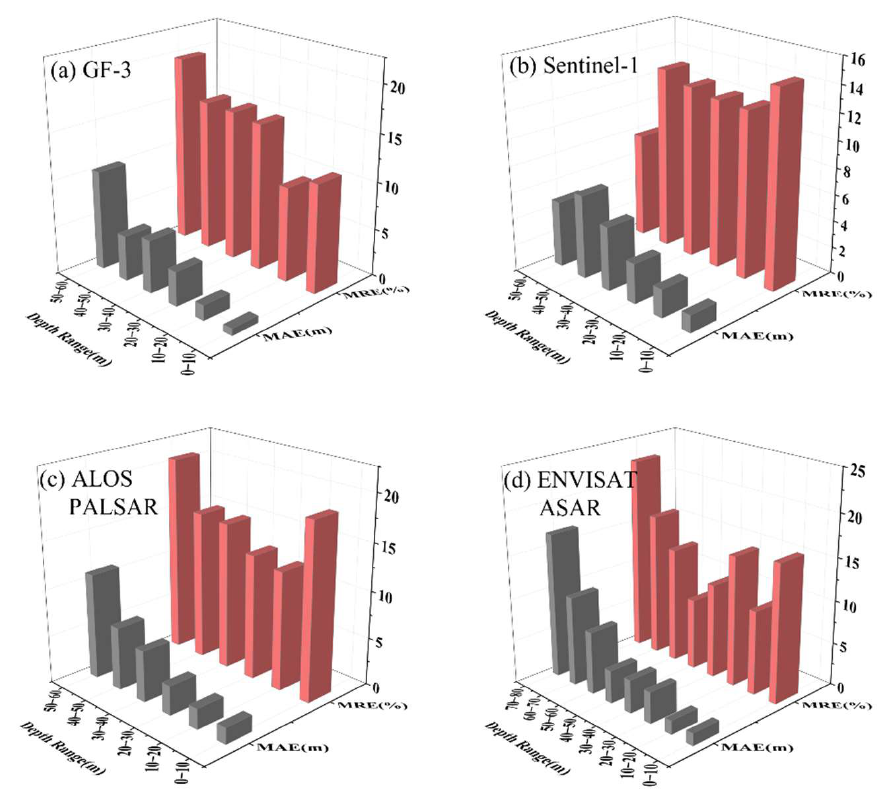
Figure 12. Error distribution in different water depth ranges. The black bar is the MAE and red bar is the MRE.